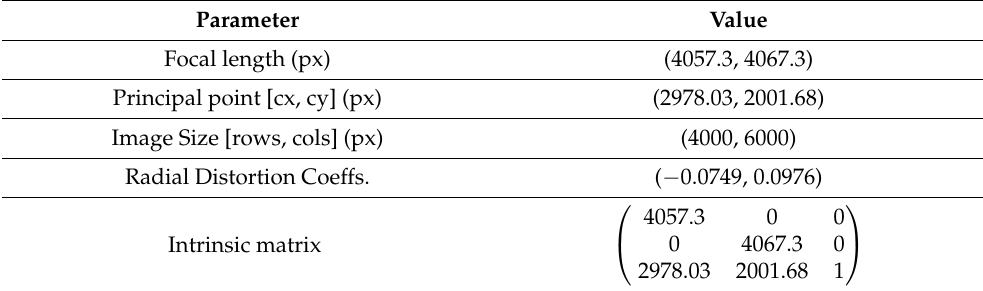
Table 5. Camera internal calibration: Results of the intrinsic parameters.